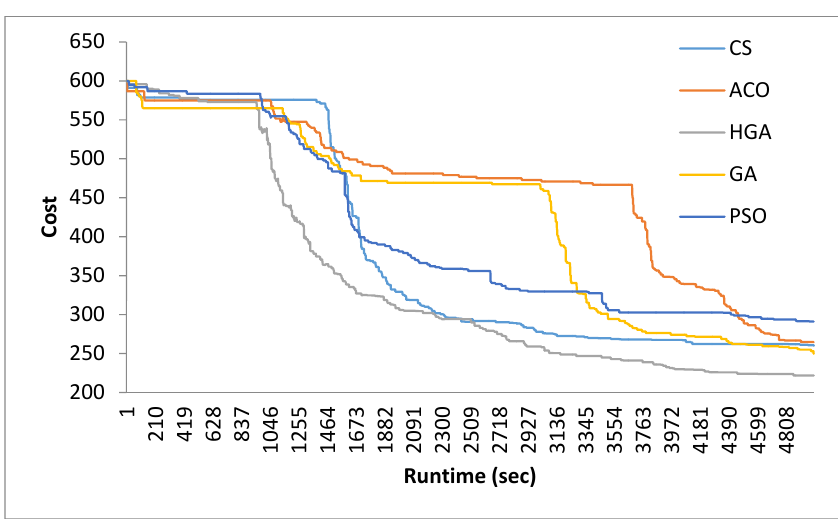
Figure 10. Plot of cost vs. runtime for 100 tasks.